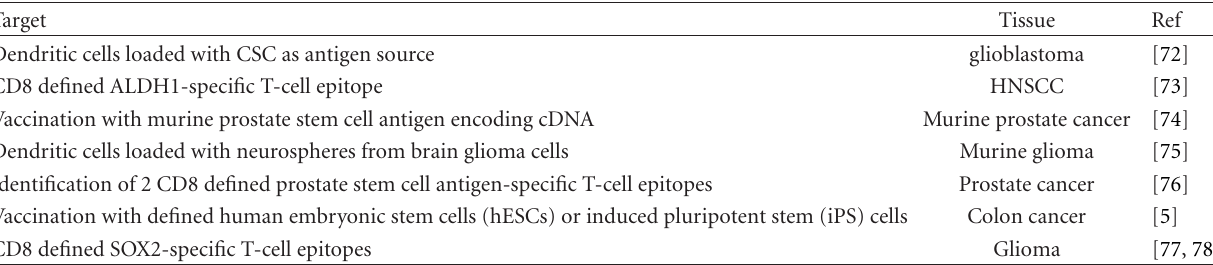
Table 2: Examples for studies targeting CSC with